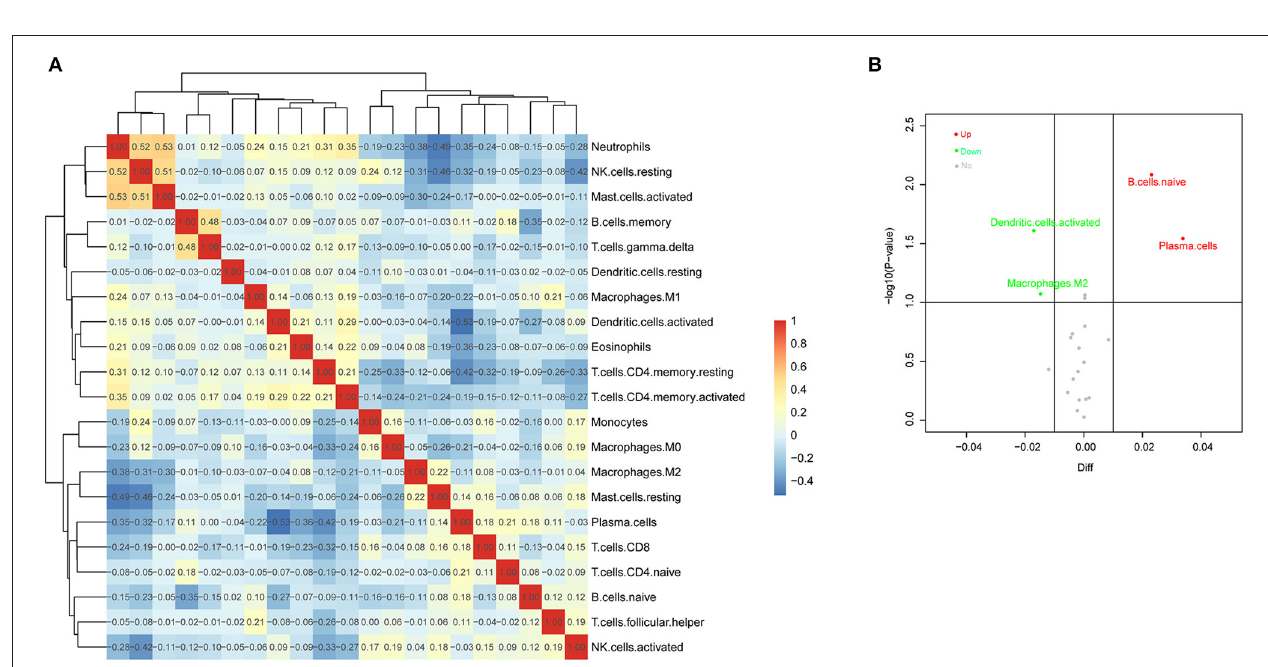
FIGURE 2 | Evaluation of immune cell infiltration in PF patients. (A) Correlation matrix of infiltrated immune cell proportion in 116 PF samples. The deeper the red and the blue, the stronger the correlation among them. (B) Volcano Plot was used to visualize features of infiltrated immune cells. The gray points referred to the immune cells subsets without significant differences, and the red and blue points refered to the immune cells subsets with significant difference. In addition, red points represented upregulation and green dots represented downregulation. PF, pulmonary fibrosis.